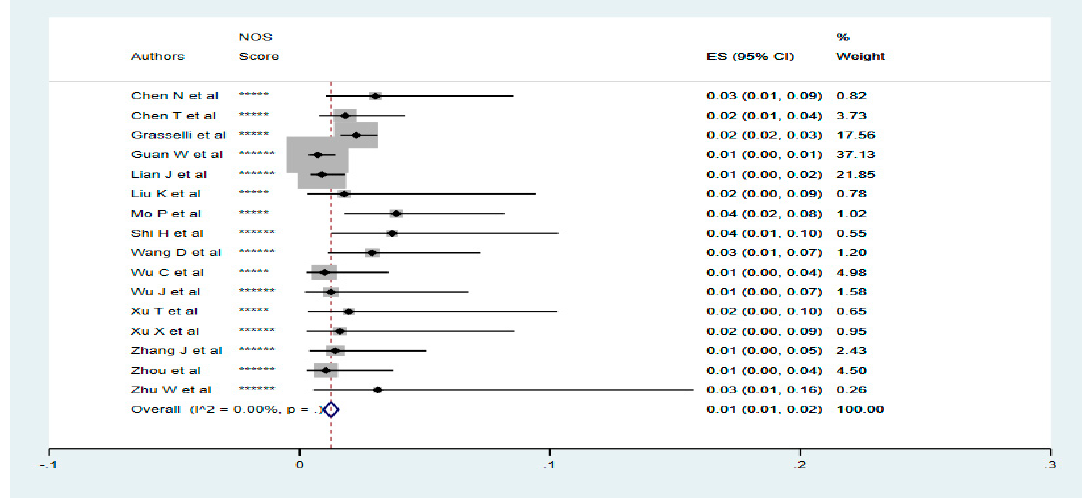
Figure 1. Risk of COVID-19 in patients with chronic liver and kidney diseases: a systematic review according to the Preferred Reporting Items for Systematic Reviews and Metanalyses diagram.